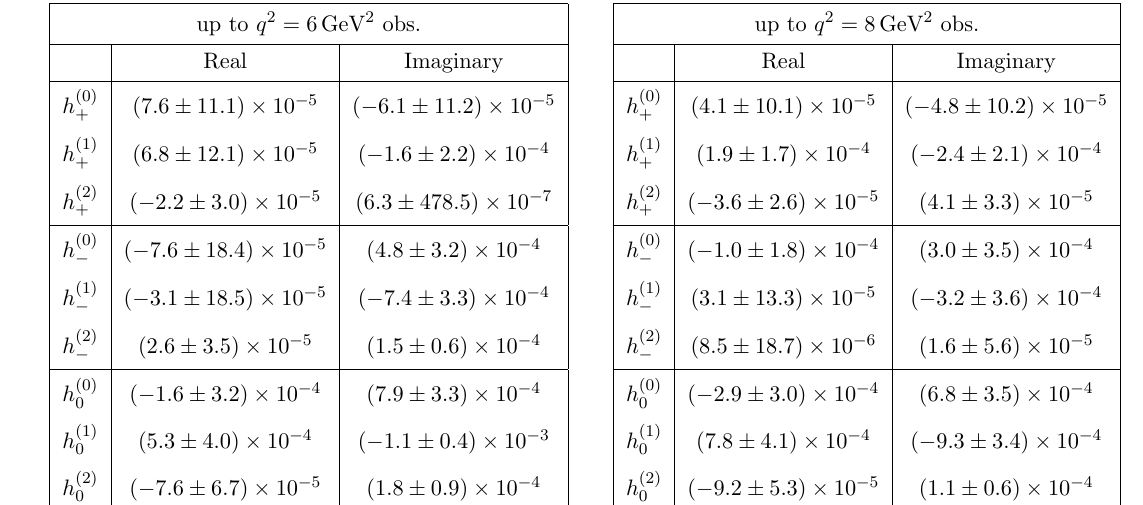
Table 8 . Fit parameters for the power corrections assuming h (0)